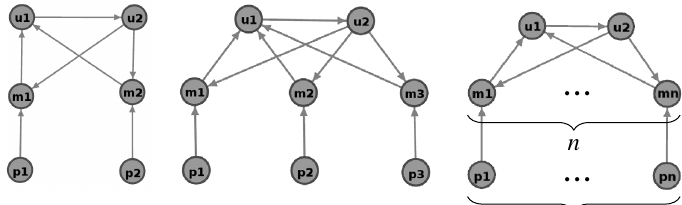
Figure 5: Integral (storage and recall) topological requirements for (from left to right) 2-bit, 3-bit and n -bit patterns. Thus, the connectivity of p - and m -register qubits is constant (1 and 3, correspondingly) as a function of pattern length, while is linear ( n + 1) for u -register